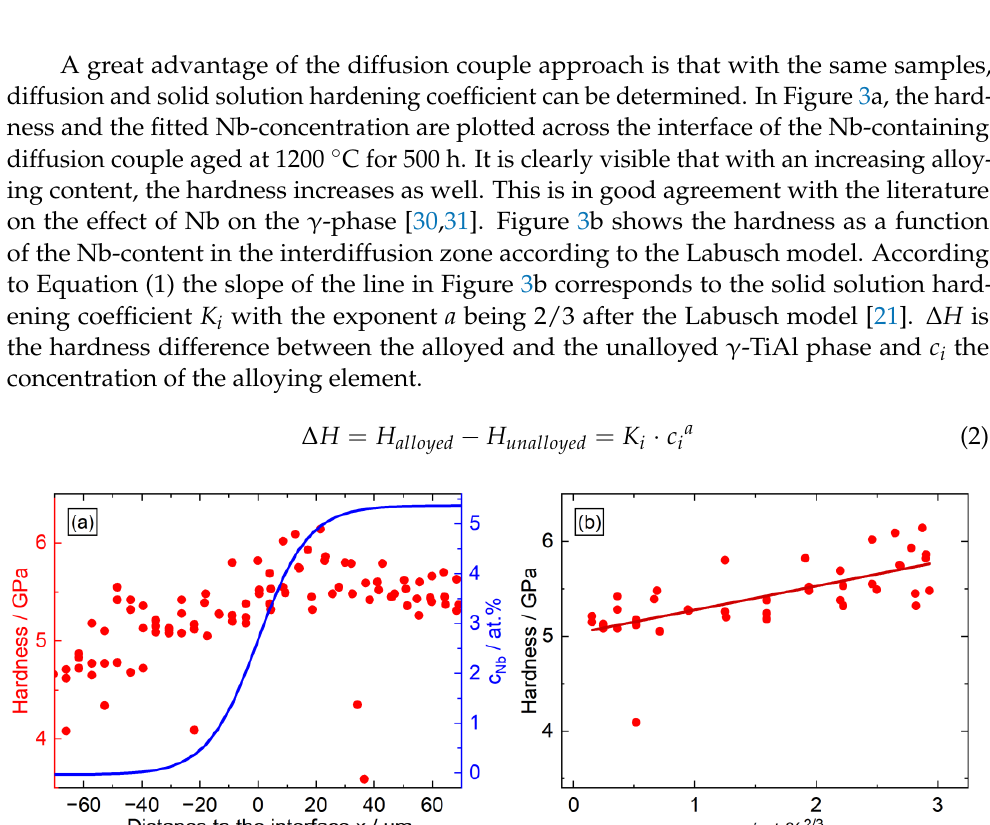
Figure 2. ( a ) Concentration C Nb of Nb across the indentation zone after annealing at 1200 °C, 1250 °C and 1300 °C and ( b ) interdiffusion coefficient D Nb as a function of the Nb concentration C Nb at three different temperatures.